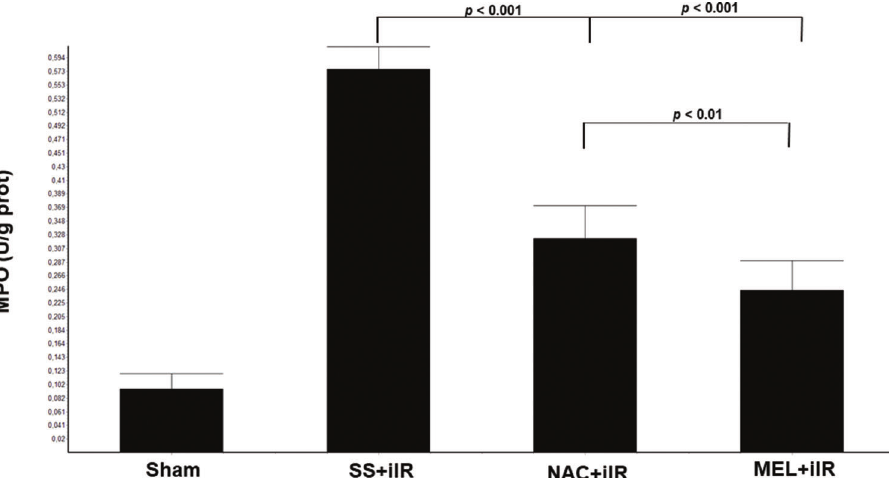
Figure 2 - Diagram showing the MPO levels of the animal groups. The MPO levels were significantly reduced before NAC and melatonin administration, the reduction was more evident in the MEL group. Data are shown as the mean ± standard deviation of seven rats in each group. Sham: control; SS + iIR: control intestinal ischemia-reperfusion (iIR); NAC + iIR: NAC administration and iIR; MEL + iIR: Melatonin administration and iIR.